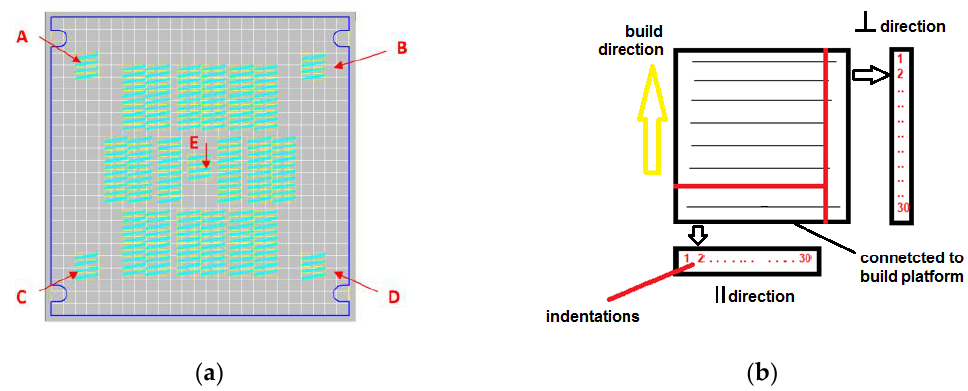
Figure 1. ( a ) Positions of samples on build platform during sintering (A – E); ( b ) collection of samples for metallographic observation.